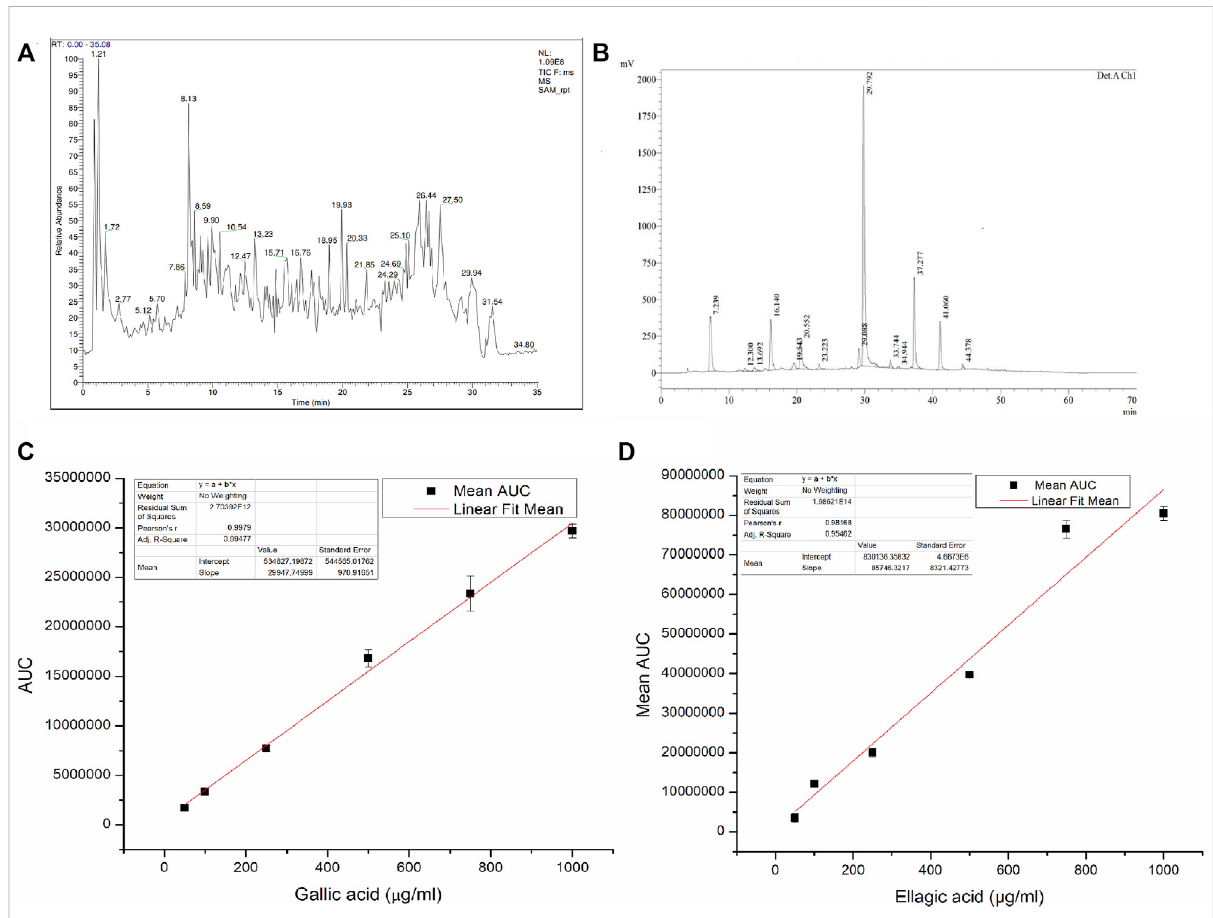
FIGURE 2 (A) LC-MS/MS spectrum of S. apetala fruit extract, (B) HPLC pro fi le of S. apetala extract, (C) Linear regression analysis for the HPLC calibration curve for gallic acid, and (D) Linear regression analysis for the HPLC calibration curve for ellagic acid.